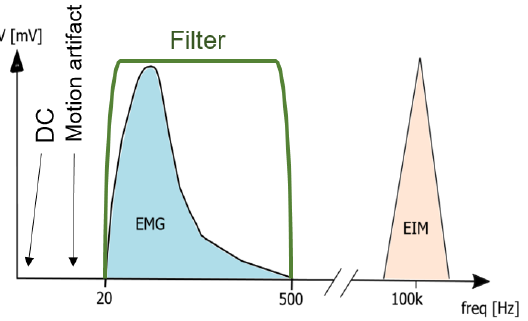
Figure 1. Spectrum of EMG and EIM signals captured at the same